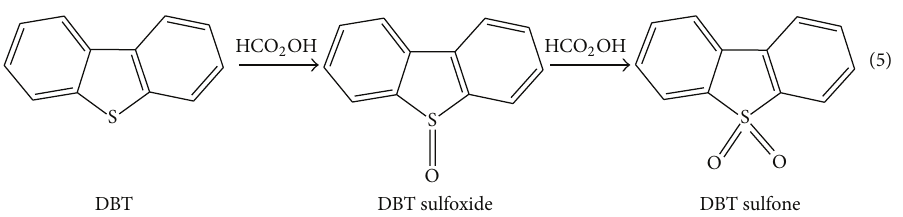
Scheme 1: ODS reaction of oxidative system and sulfur